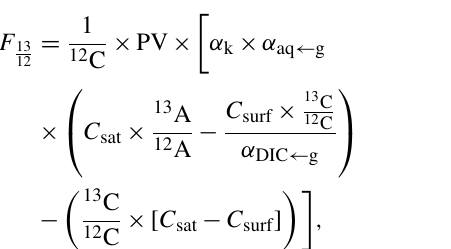
1 = × PV F 13 12 C 12